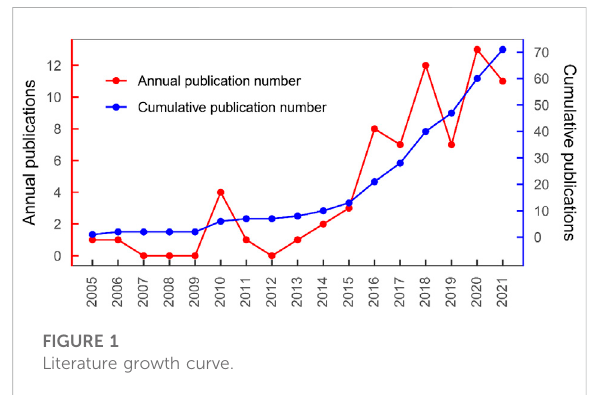
FIGURE 1 Literature growth